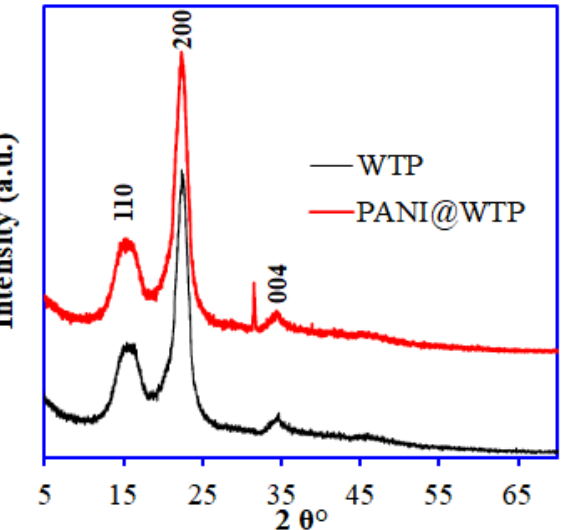
Figure 2. XRD pattern of WTP and PANI@WTP nanocomposite.